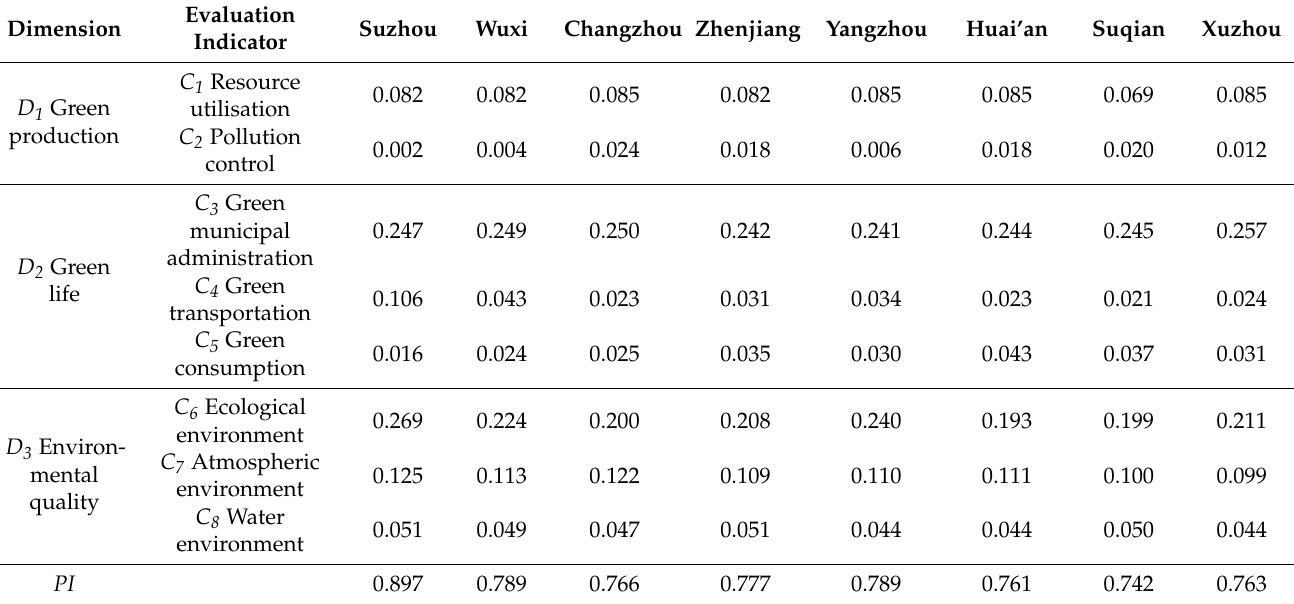
Table 11. Results of evaluation for 2019.